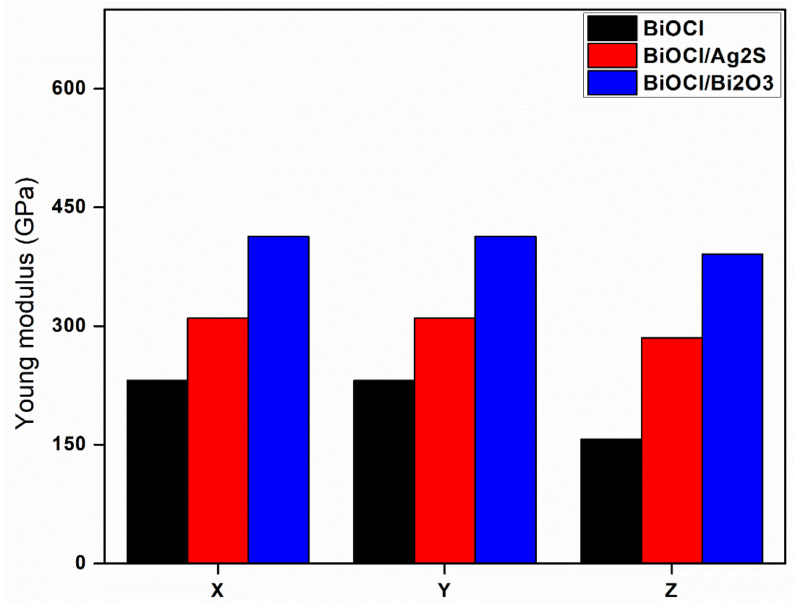
Figure 6. Young’s modulus of elasticity of BiOCl, BiOCl/Bi 2 O 3 , and BiOCl/Ag 2 S in three directions (x, y, and z).